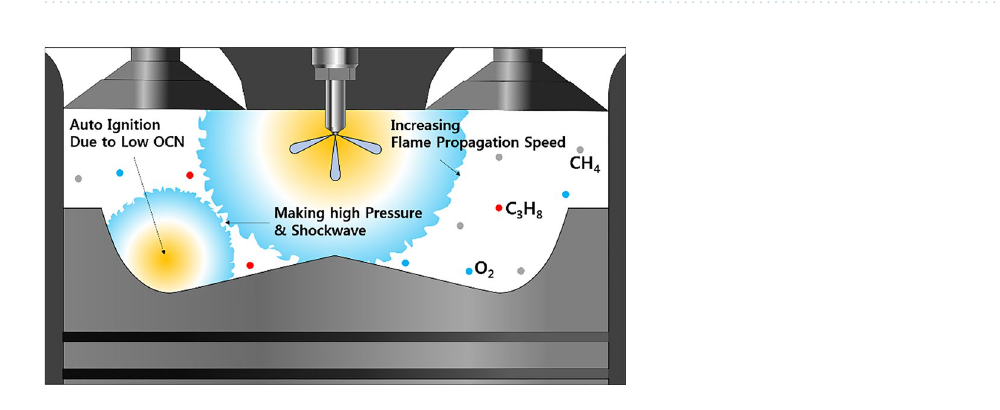
Figure 9. Schematic of effects of C 3 H 8 on MPDF